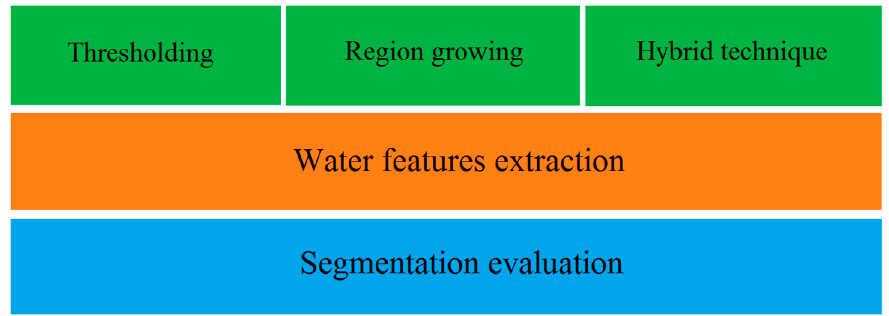
Figure 1. The overall procedure of this study.